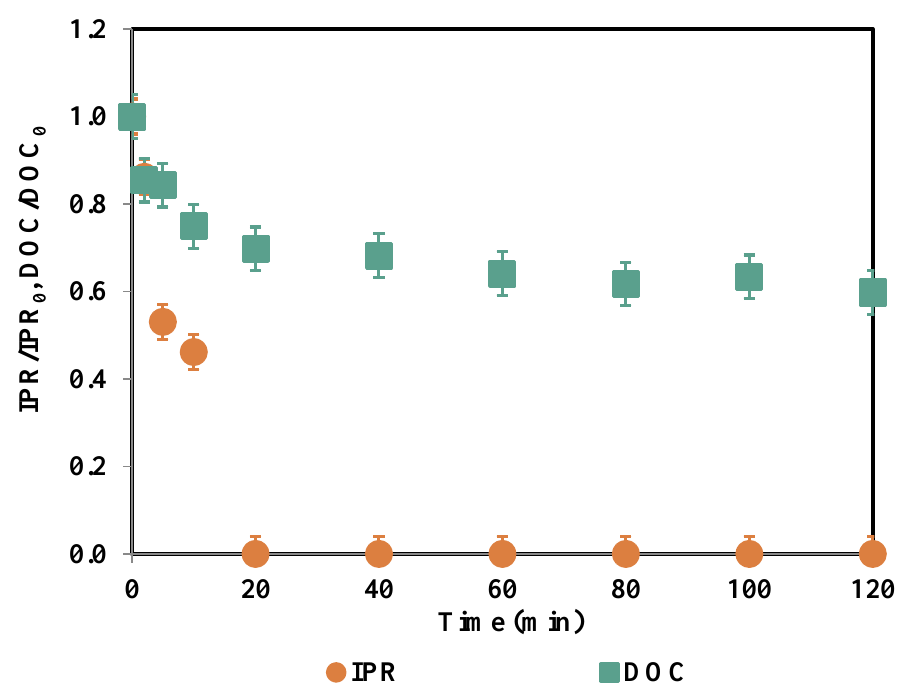
Figure 9. Changes in normalized IPR and DOC during ZVI/PS treatments in SWW. IPR = 2 mg/L; DOC = 11.4 mg/L; PS = 1.50 mM; ZVI = 1 g/L, pH = 3.0.